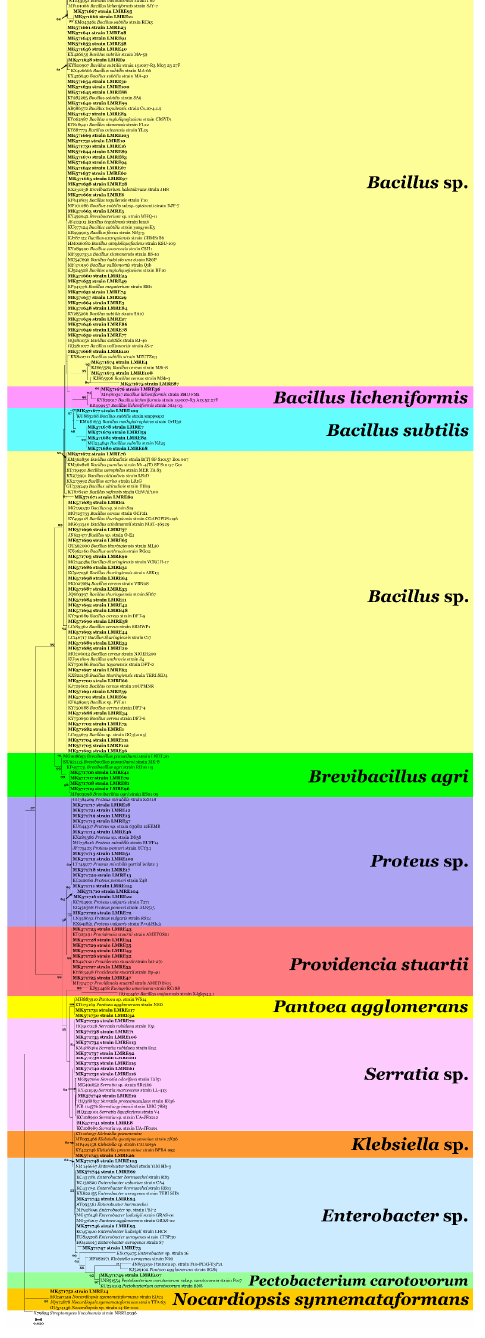
Figure 1. Neighbor-joining phylogenetic tree of Gram-positive and Gram-negative bacteria. The tree was constructed using sequences of 16S-rDNA and rooted to Streptomyces lincolnensis strain NRRL2936. Scale bar, number of expected changes per